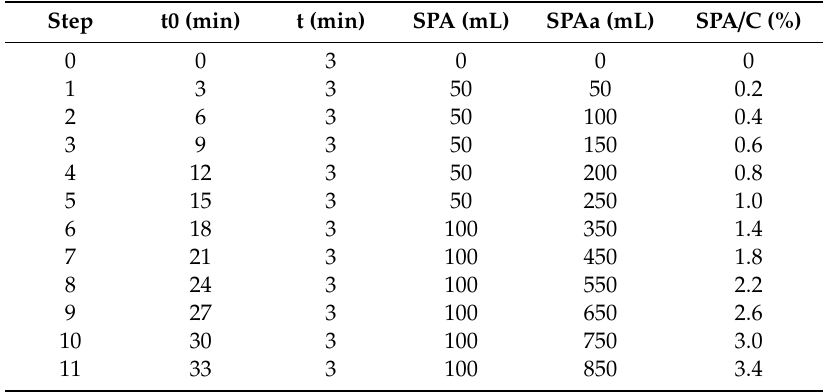
Table 4. Evolution of the amount of superplasticiser admixture (SPA) in the concrete.